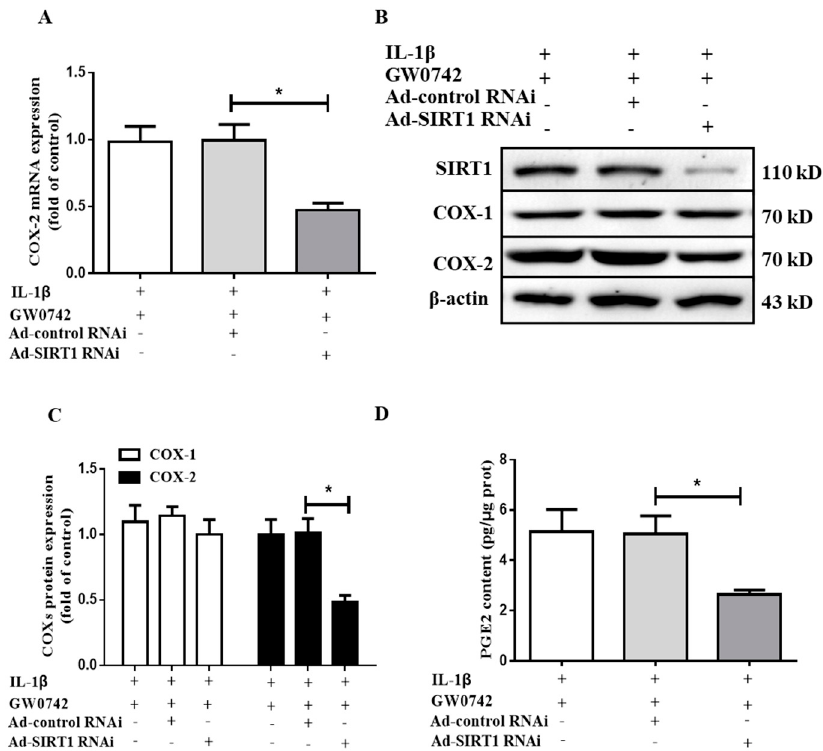
Figure 7. SIRT1 gene silencing abolishes the stimulatory effect of PPAR β / δ on IL-1 β -induced COX-2 expression and PGE2 production in human mesangial cells. After infection with Ad-siSIRT1 (10 MOI) or Ad-siControl (10 MOI), the cells were pretreated with GW0742 (1 µ M) for 6 h and then treated with IL-1 β (5 ng/mL) for 12 h. ( A ) Ad-siRNA-mediated SIRT1 gene knockdown abolished the stimulatory effect of PPAR β / δ on IL-1 β -induced COX-2 mRNA expression, as assessed with real-time PCR. ( B , C ) The effect of SIRT1 gene knockdown on SIRT1, COX-1, and COX-2 protein expressions was measured using Western blot. ( D ) The effect of SIRT1 gene silencing on PGE2 production. * p < 0.05 vs. IL-1 β + GW0742 + Ad-siControl; n = 4.